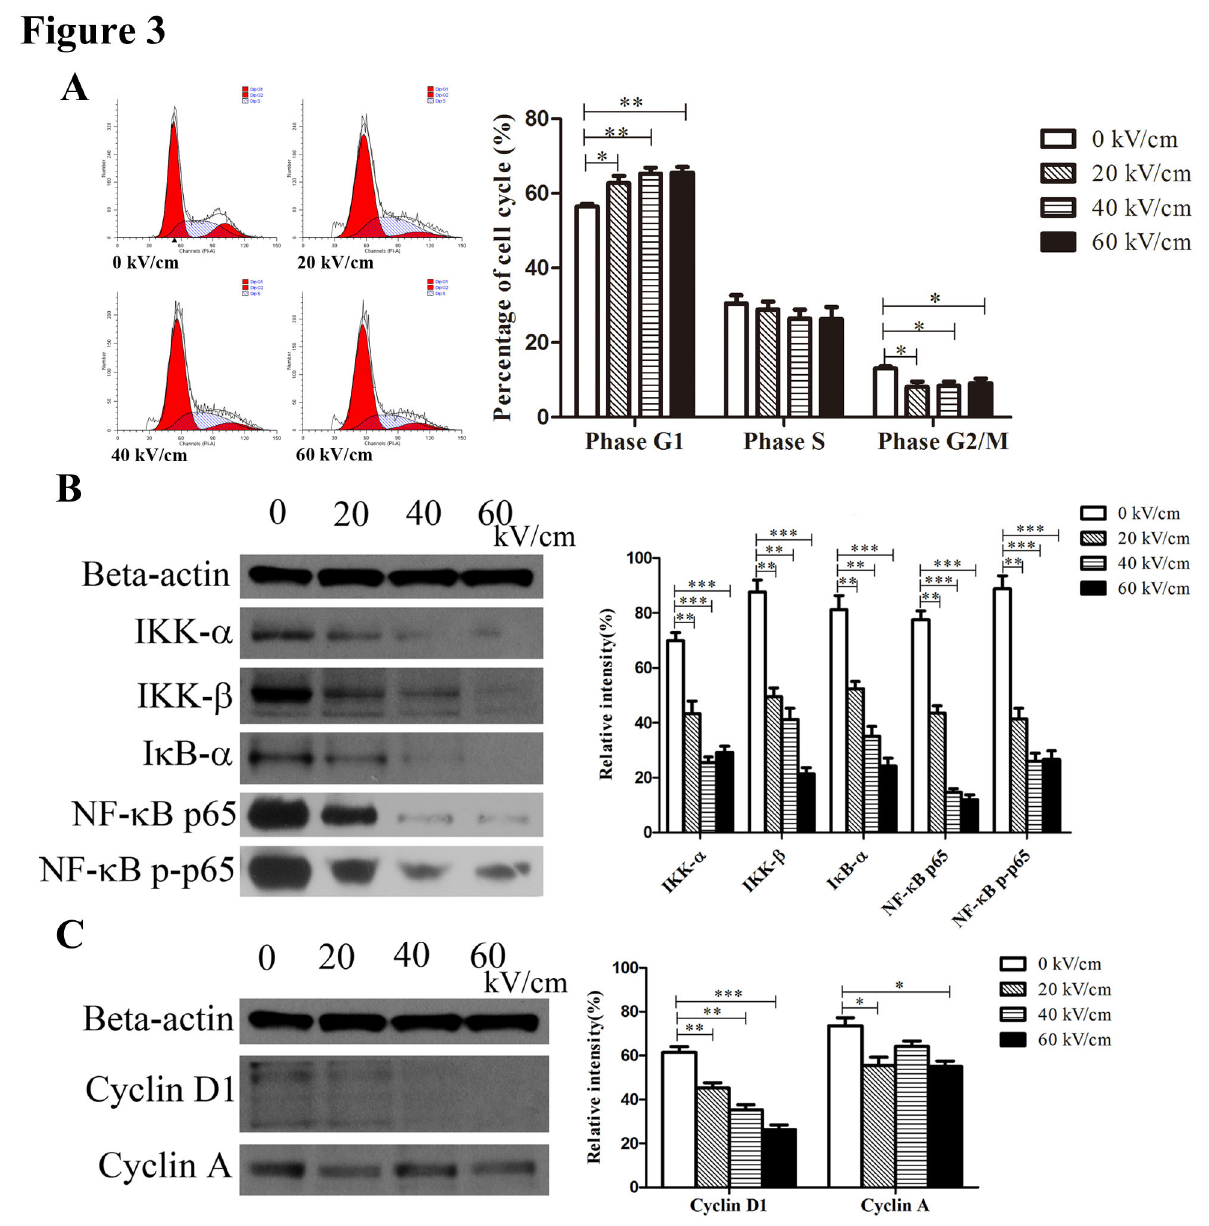
Figure 3. NsPEF inhibits cell proliferation through repressing NF-κB signaling pathway to reduce expressions of Cyclin proteins in vitro. (A) Cell cycle of cancer cells exposed to nsPEF with different intensities was examined with PI staining assay by flow cytometry, and results were analyzed by FlowJo 7.6.1 Software. *p<0.05, **p<0.01. (B) Protein expressions of NF-κB signaling pathway including IKK-α, IKK-β IκB–α, p65 and p-p65 in cancer cells after exposure to nsPEF with different intensities were detected by Western-blot assay. (C) Protein expressions of Cyclin proteins including Cyclin D1 and Cyclin A in cancer cells after exposure to nsPEF with different intensities were detected by Western-blot assay. Relative intensity of each protein was analyzed by Photoshop CS4 software. *p<0.05, **p<0.01, ***p<0.001.